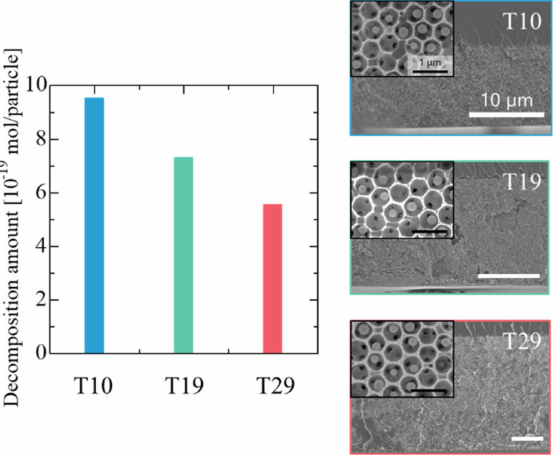
Figure 4. Decomposition amounts of methylene blue (MB) per a single TiO 2 particle of T10 ( T = 10 µ m), T19 ( T = 19 µ m), and T29 ( T = 29 µ m) 5 h after the photocatalytic reaction started. SEM images on the right are cross sections and top views (inset) of each